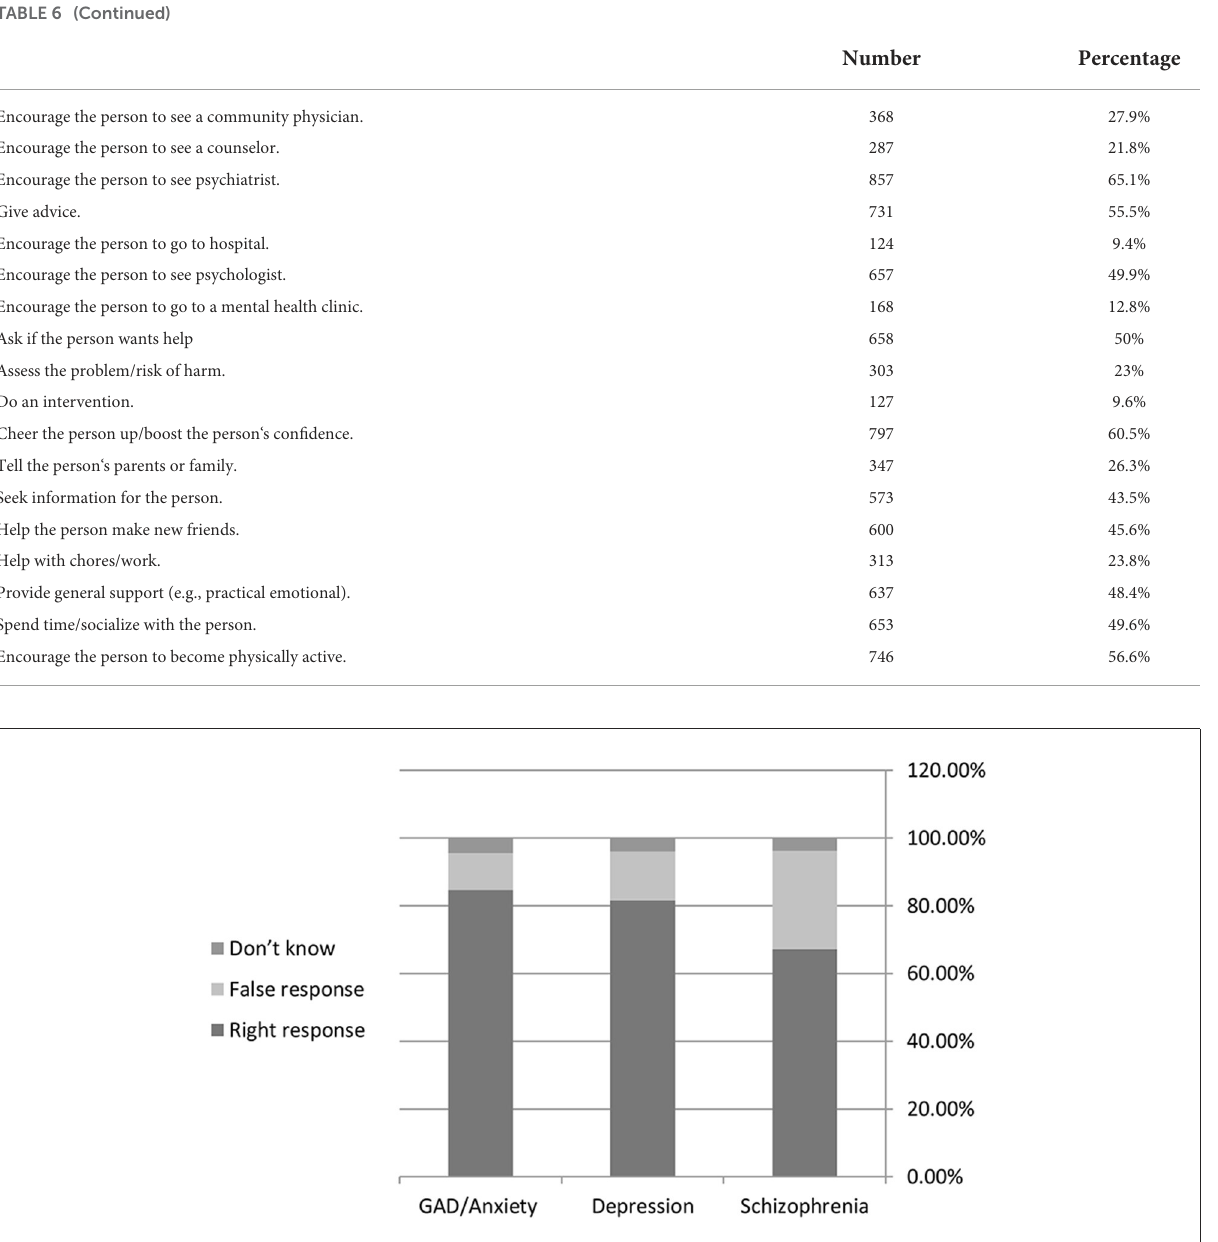
FIGURE2 Supporting information: (Knowledge toward the three mental